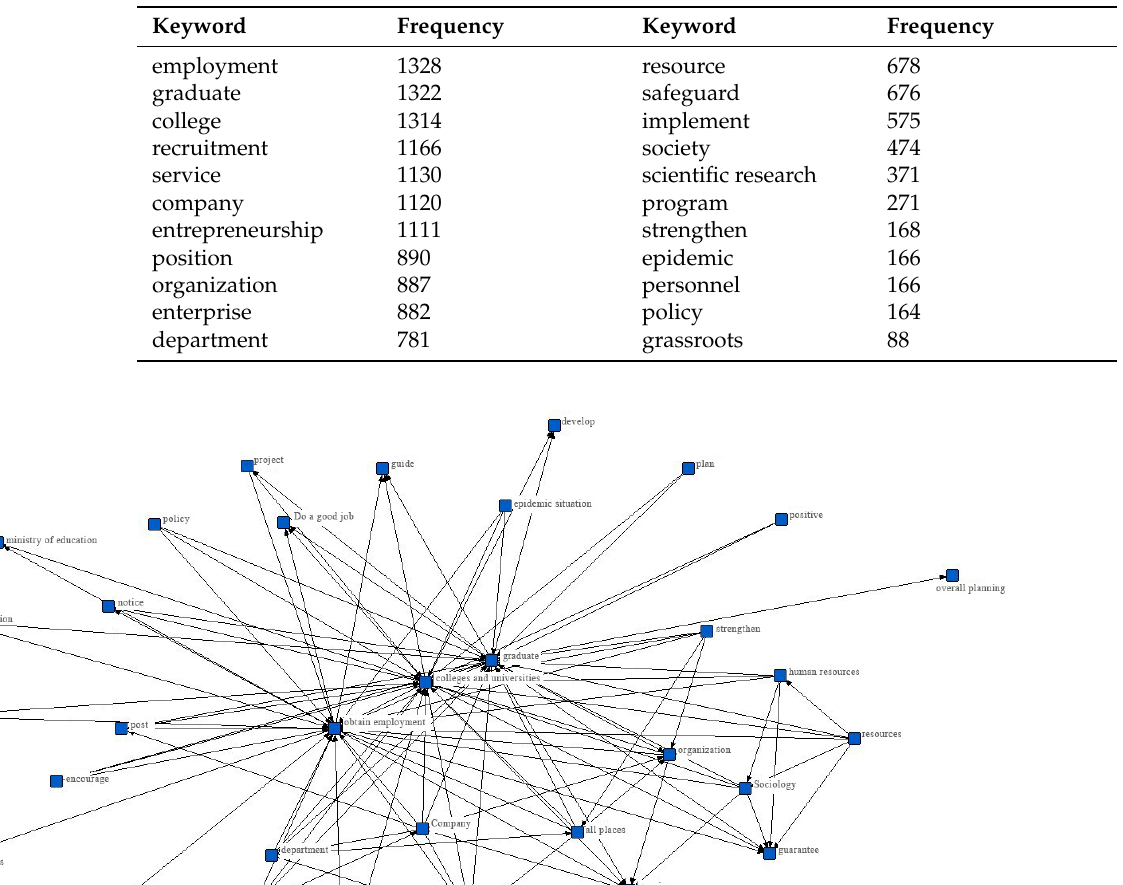
Table 2. Statistics of keyword frequency in employment promotion policy documents for college graduates.